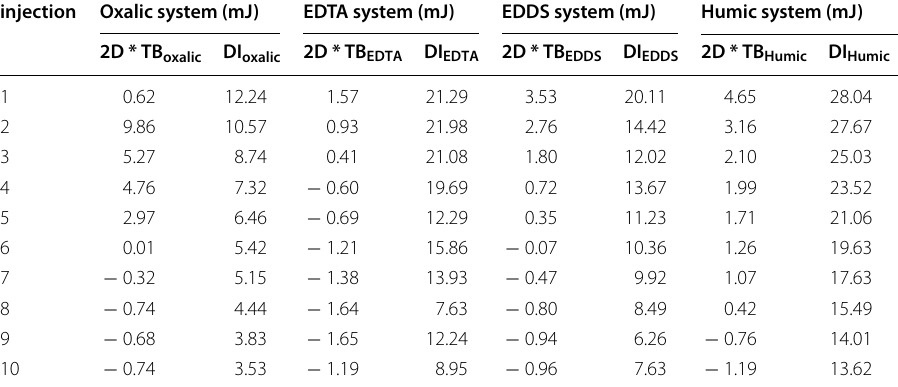
TB (rock–fluid interactions) +